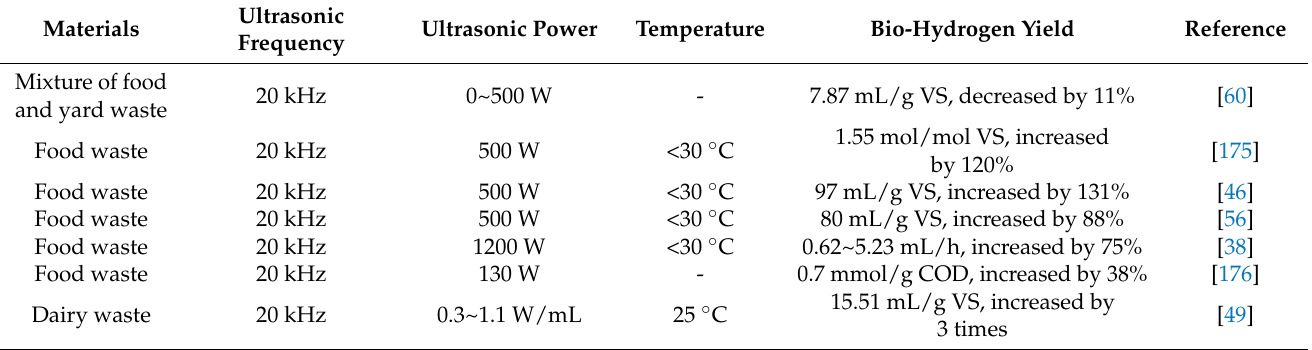
Table 5. Effect of ultrasound on bio-hydrogen production from food waste during